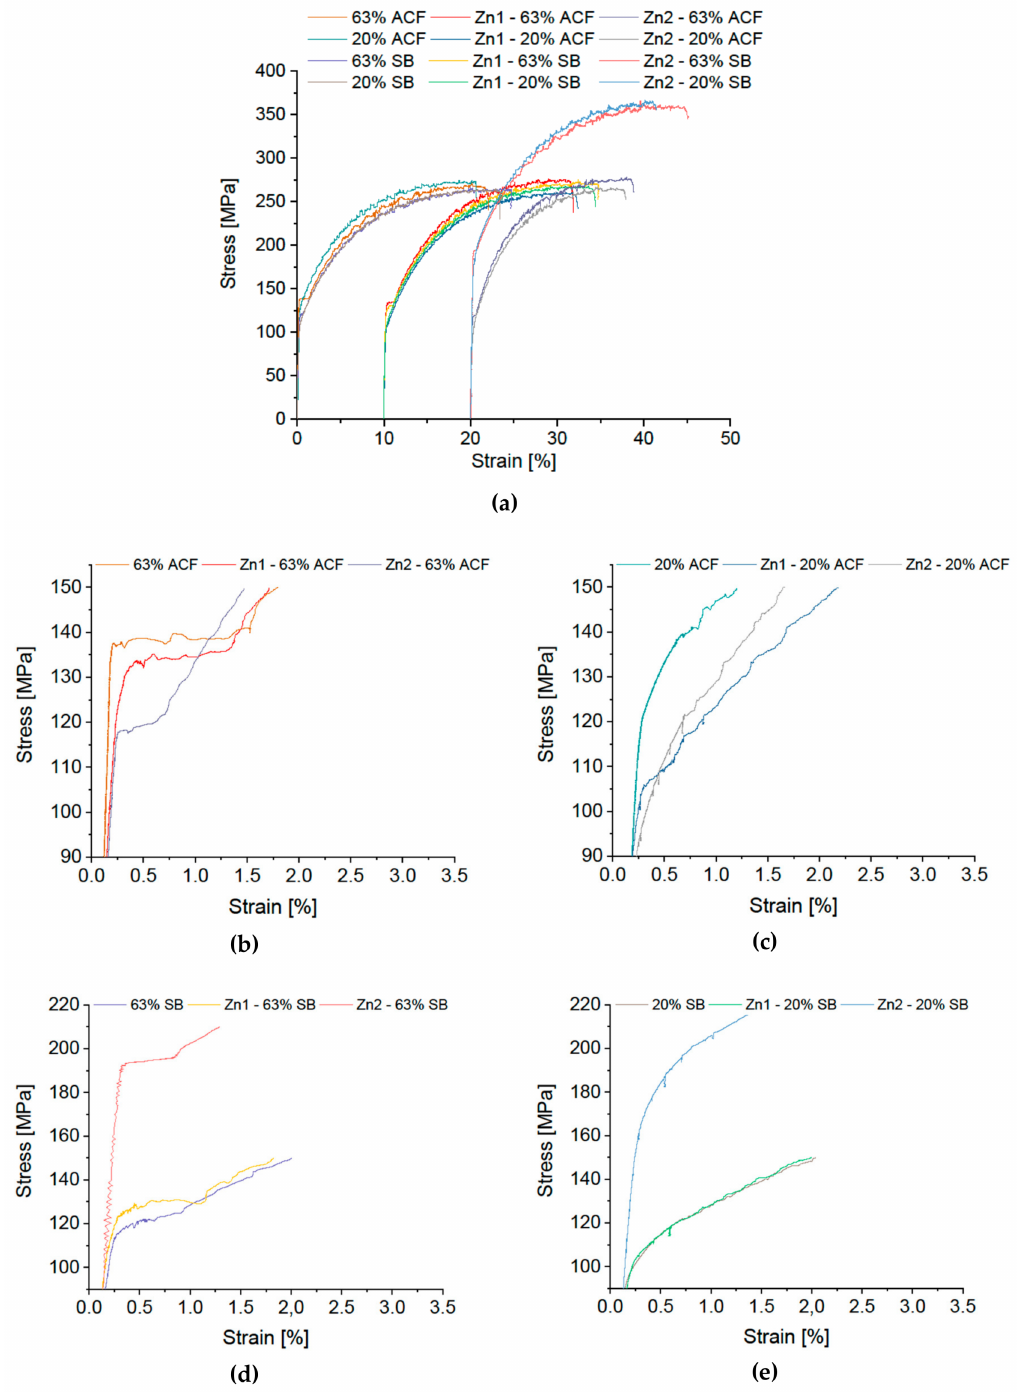
Figure 8. Stress-strain diagram of modified EN AW-5182 with di ff ering Zn content. ( a ) Overview; Details of Lüders elongation: soft annealing in ACF at 370 ◦ C with ( b ) 63% and ( c ) 20% cold rolling, salt-bath treatment at 500 ◦ C with subsequent water quenching with ( d ) 63% and ( e ) 20% cold rolling. Please note the di ff erent scale in ( a , d , e